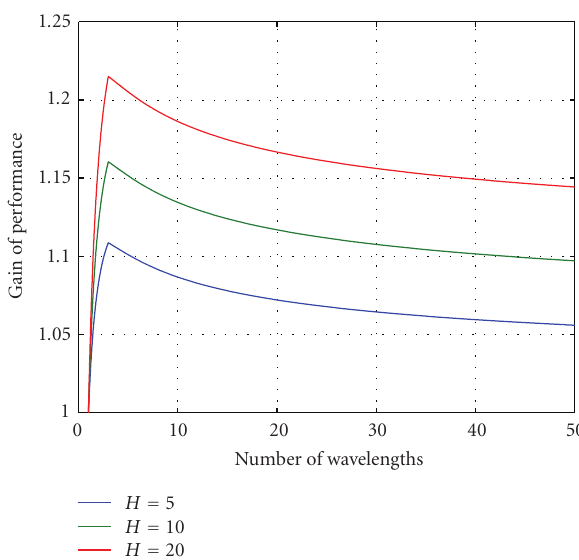
Figure 7: The gain of wavelength conversion G W = f ( W ), P b = 10 − 3 , F = 10, and Full/No.